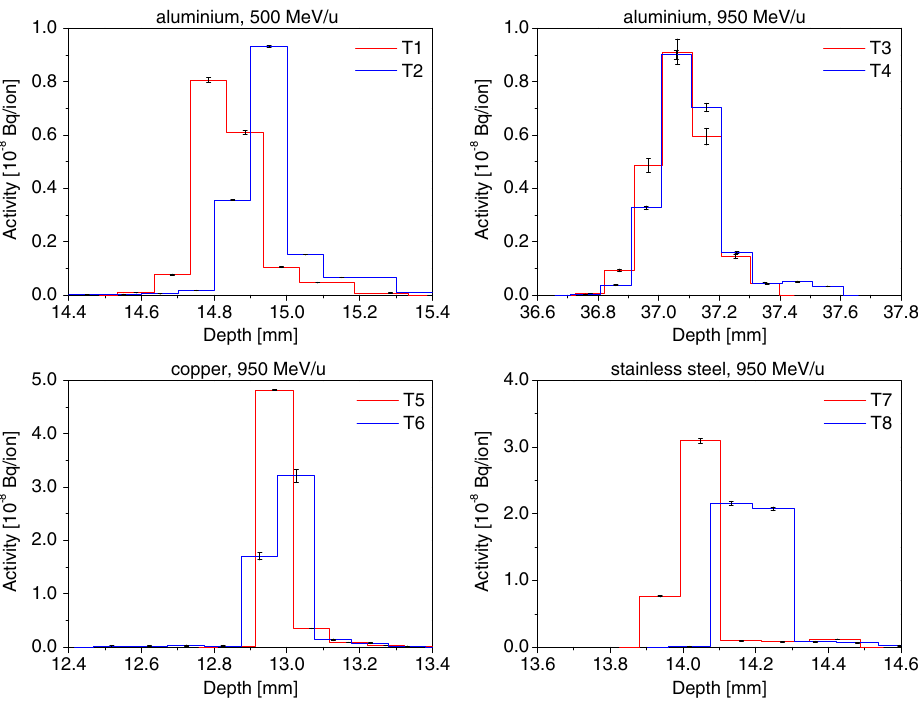
FIG. 3. Experimental depth profiles of the 237 U residual activity in the aluminum, copper, and stainless-steel targets irradiated with 238 U primary beam with the initial energy 500 and 950 MeV = u .